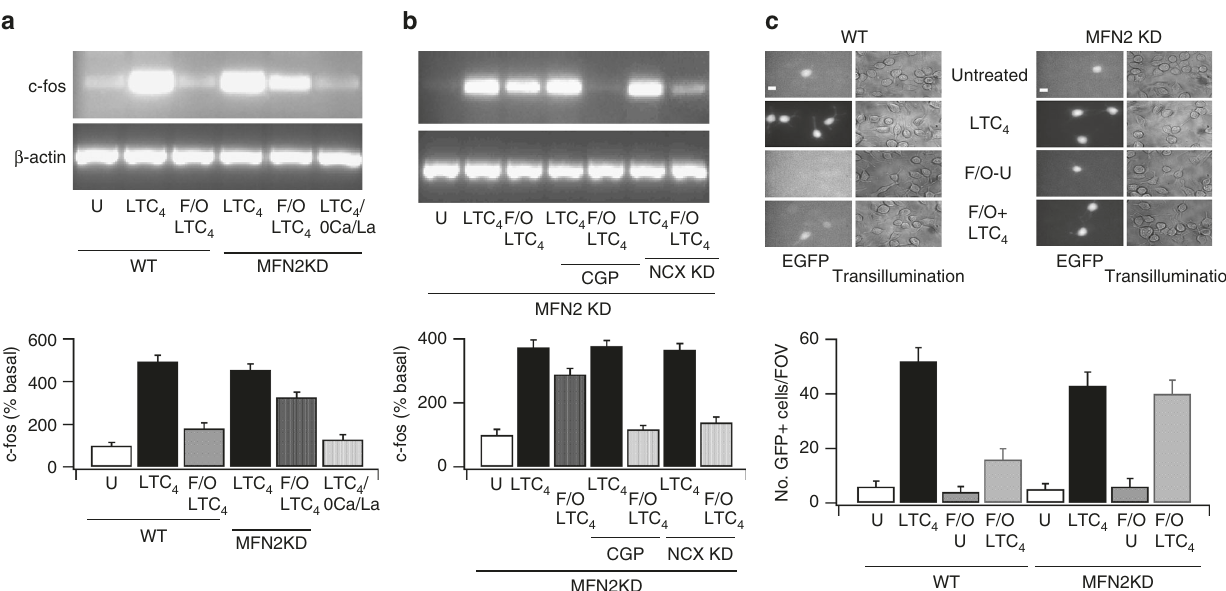
Fig. 4 Functional Na + – Ca 2+ exchange supports gene expression in cells with de-energised mitochondria. a LTC 4 -induced c-fos gene transcription is reduced by FCCP but rescued following knockdown of mitofusin 2. Lower panel shows aggregate data from three independent experiments. U denotes untreated, F/O FCCP and oligomycin. F/O was applied 5 min prior to stimulation. LTC4/0Ca/La denotes the lack of c-fos response in the absence of Ca 2+ in fl ux, despite sustained cytosolic Ca 2+ oscillations 25 . b In mitofusin 2-de fi cient cells, rescue of LTC 4 -induced c-fos transcription in the presence of mitochondrial depolarisation is prevented by either CGP-37157 (labelled CGP) or knockdown of the Na + – Ca 2+ exchanger (NCX KD). c NFAT-dependent reporter gene expression is compared for the different conditions shown. The left-hand panel denotes wild-type cells and the right-hand panel responses after knockdown of mitofusin 2. Bar plot in the lower panel denotes aggregate data for the various conditions shown. FOV on y -axis is Field Of View. Here, FCCP and oligomycin were applied 5 – 10 min before stimulation with LTC 4 . Agonist and FCCP/oligomycin were removed after a further 8 min. Scale bar denotes 10 μ m. Error bars denote